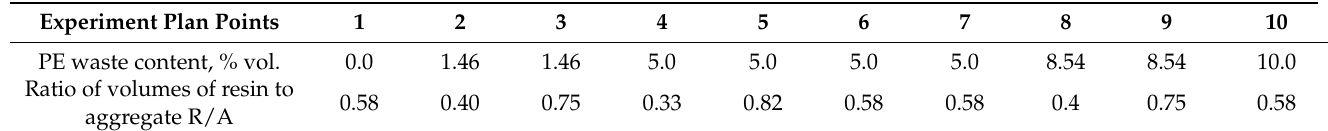
Table 1. The composition of the mortar for individual points of the experiment plan. Experiment Plan Points PE waste content, %